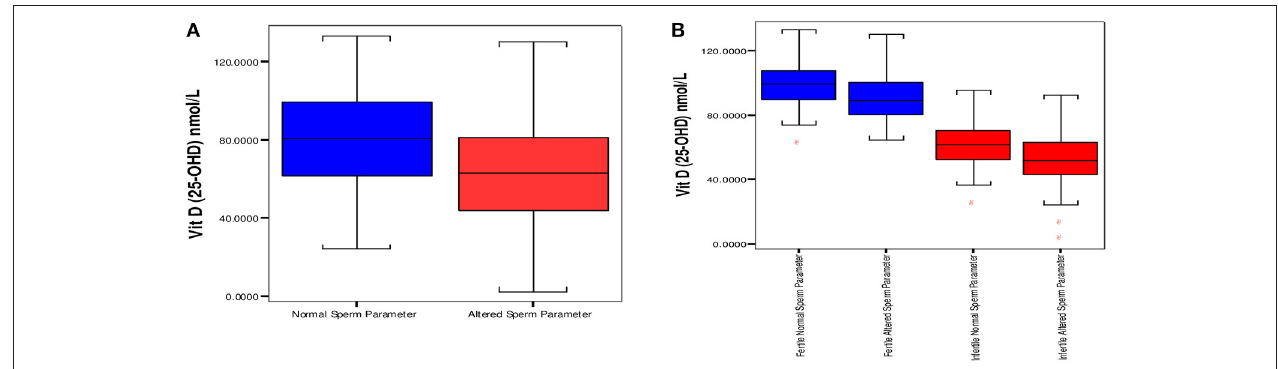
FIGURE 2 | Distribution of vitamin D between groups having “normal” and “altered sperm parameter/s.” (A) Box plot of median 25 and 75th percentiles showed dissimilar distribution of vitamin D between normal and altered sperm parameters. (B) Comparison of Vitamin D among fertile and infertile groups having “normal” and “altered sperm parameter/s.” Normal sperm parameters = total sperm count > 39 milion sperm per ejaculate, motility > 40%, and normal morphology ≥ 4%. Aitered sperm parameter = total sperm count < 39 million sperm per ejaculate, motility < 40% and normal morphology < 4% (at least one parameter is altered).